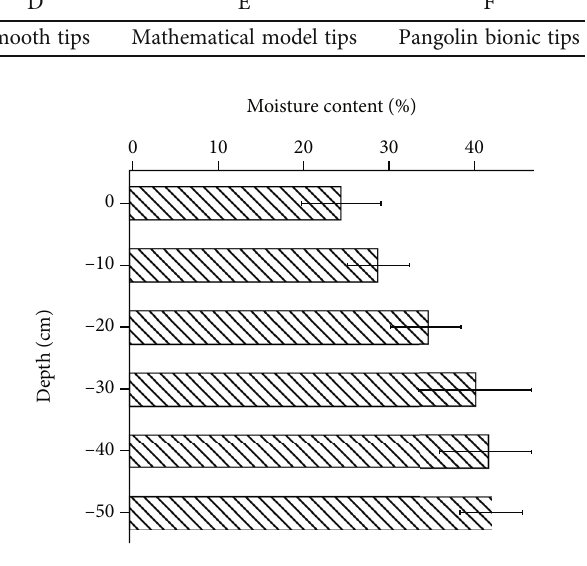
Figure 9: Variation of water content with depth. Table 4: Soil particle size distribution at di ff erent